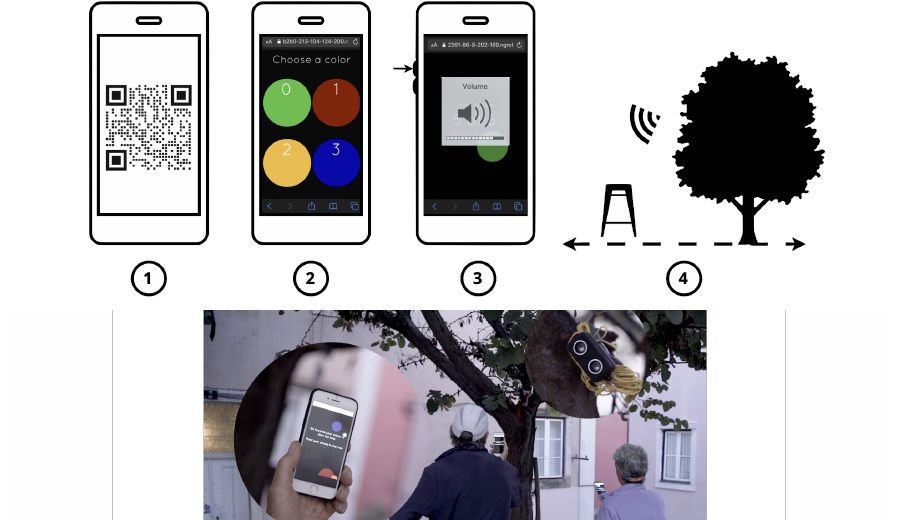
Figure 8. User instructions for installation: (1) Access QR code; (2) Load the app and select a colour; (3) Increase the device volume, and (4) Walk towards the chosen colour to initiate